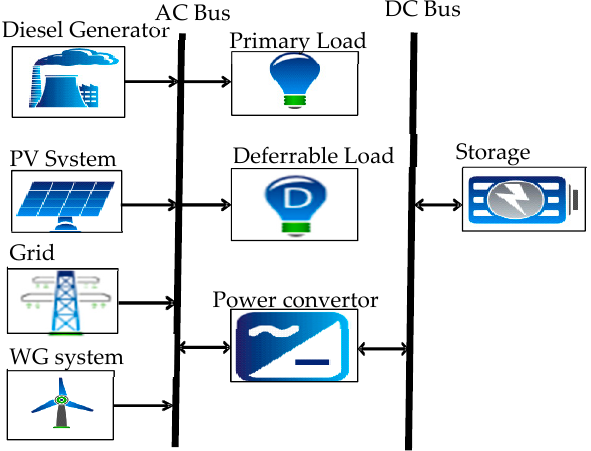
Figure 7. Schematic diagram of minigrid hybrid renewable energy system.